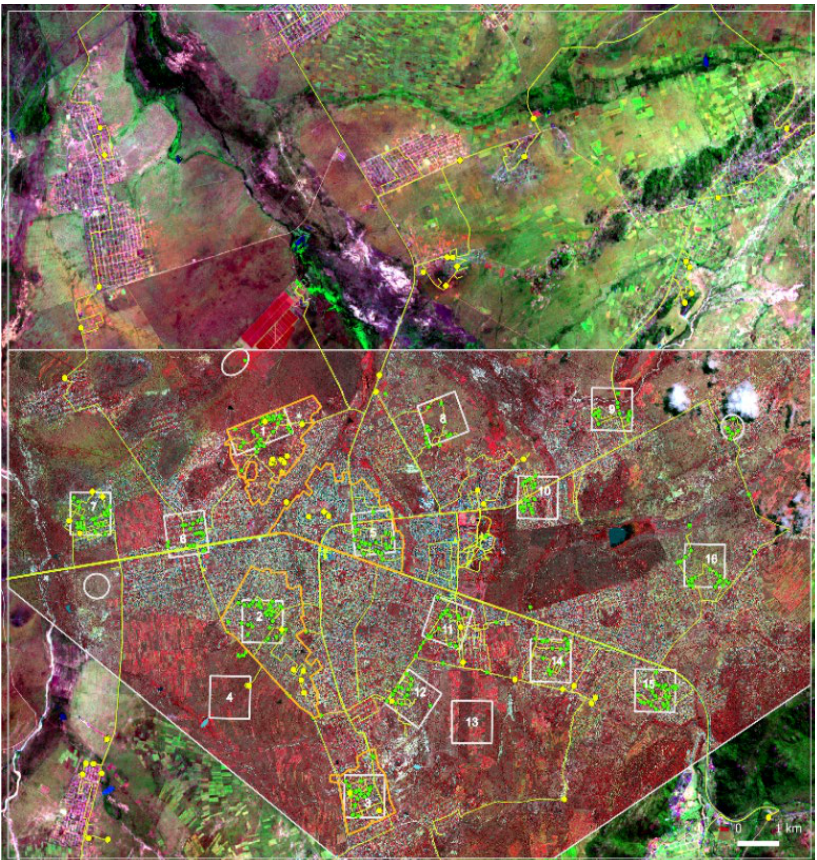
Figure 1: Study area (-23.90 Lat, 29.72 Long) with the four WoPedyP study sites (orange), ground truth sites delineated by square or circular polygons (white), ground truth points (green from 1st visit, yellow from 2nd visit) and tracks (yellow) overlaid on World- View-3 (20 March 2022; bands 7,5,3) and Sentinel-2 (11 April 2021; bands 10,7,2)